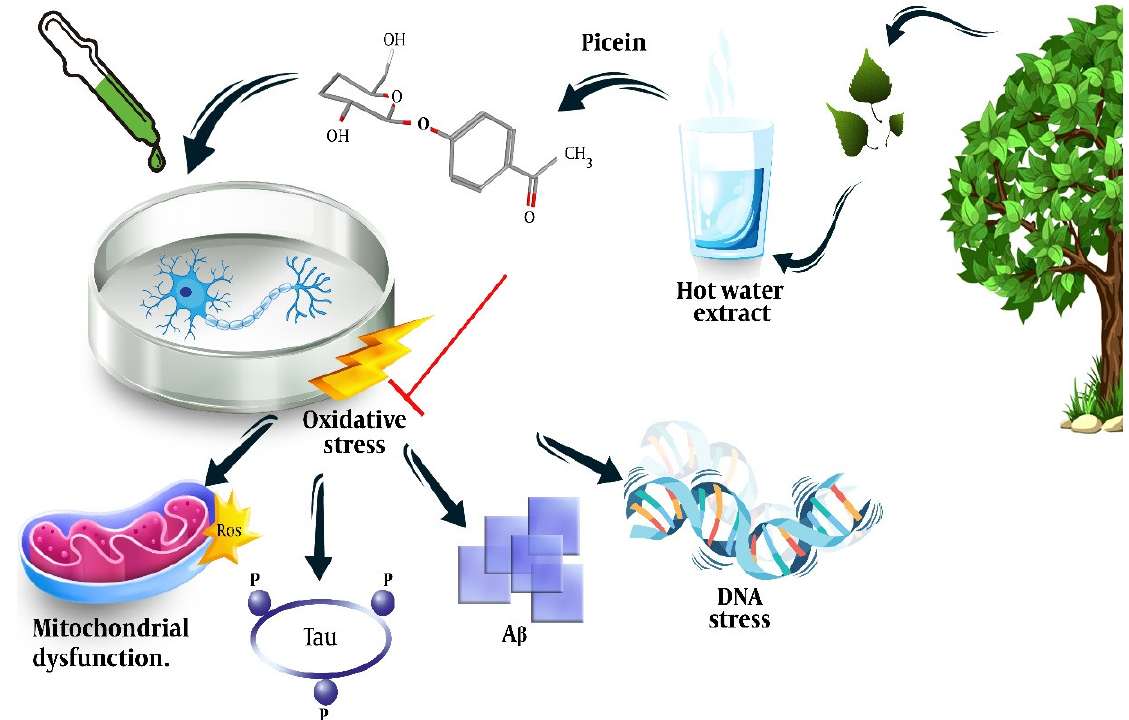
Figure 2. Isolation of picein from willow bark, its chemical formula, and illustration of the mecha- nisms behind its neuroprotective effects. Adapted from ref. [72].